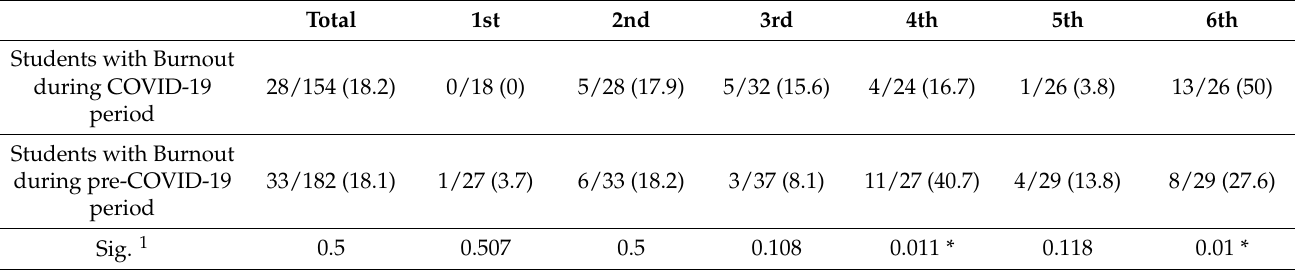
Table 1. Burnout prevalence across academic years in the different COVID-19